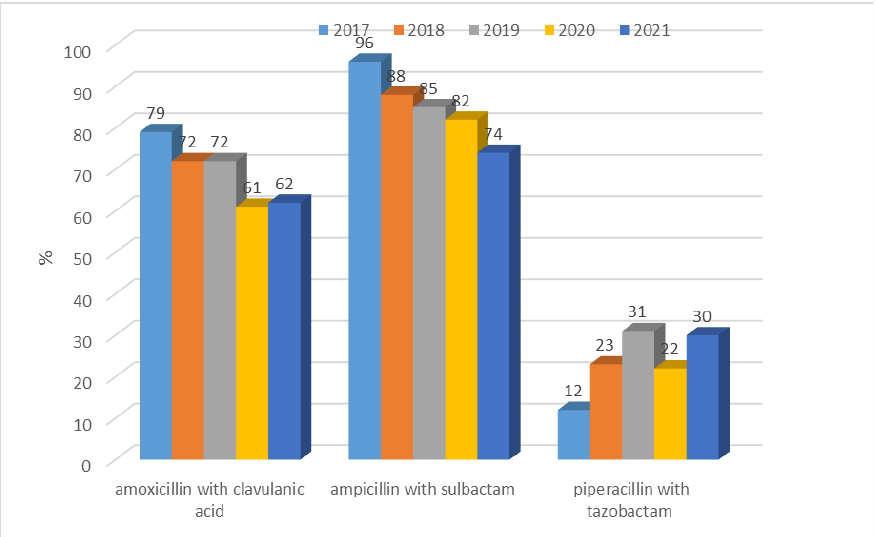
Figure 4. Percentage of E. coli ESBL(+) strains resistant to penicillins with